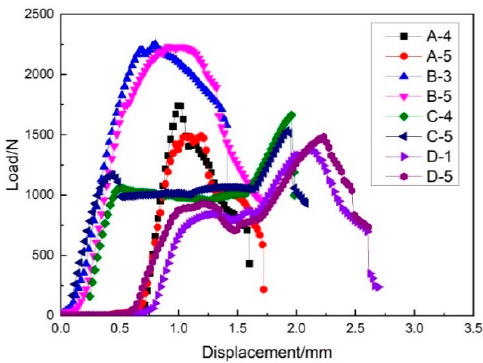
Figure 21. Load–displacement curve of weft compression.